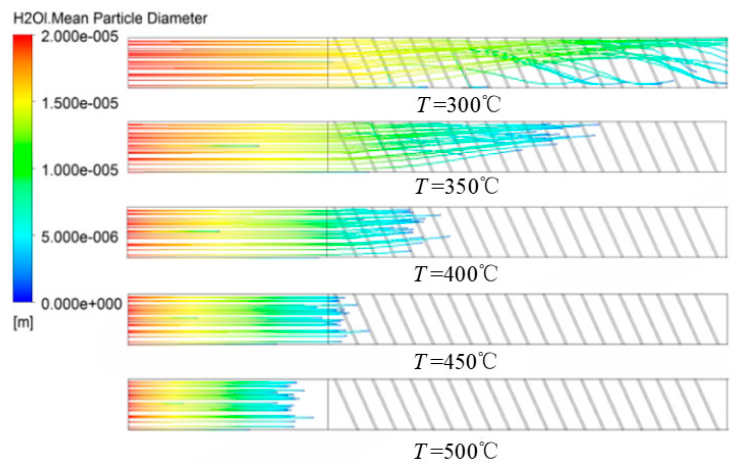
Figure 7. Variation in Nusselt number distribution of the ribbed surface of the mist/steam cooling channel with the coolant temperature.